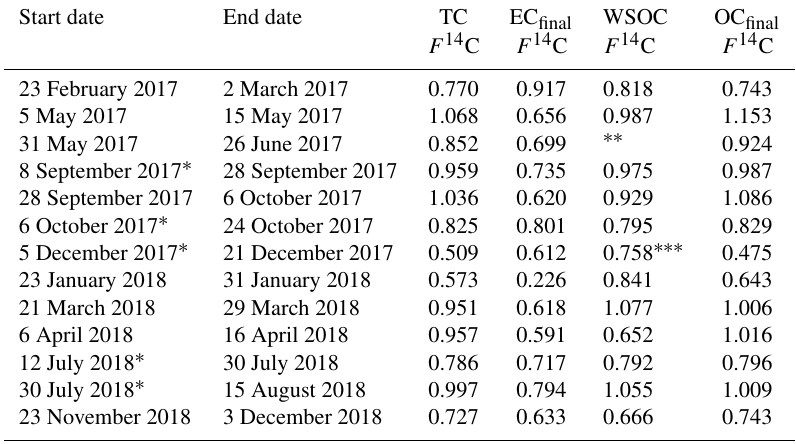
Table 5. Final radiocarbon results for each fraction after all calculations and corrections described in this